Question: What type of chart is this?
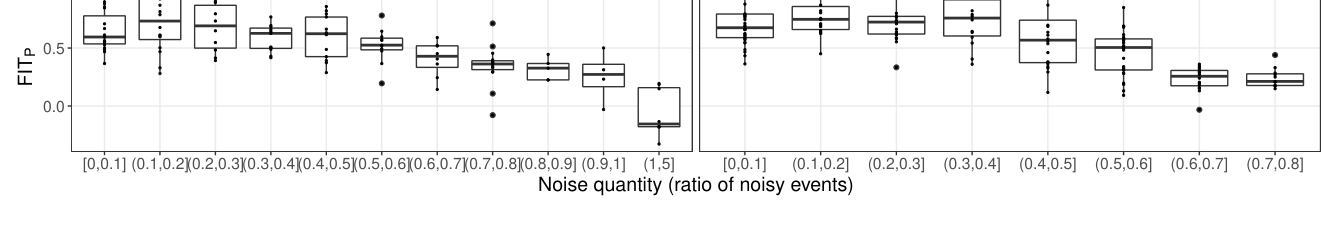
Answer: line